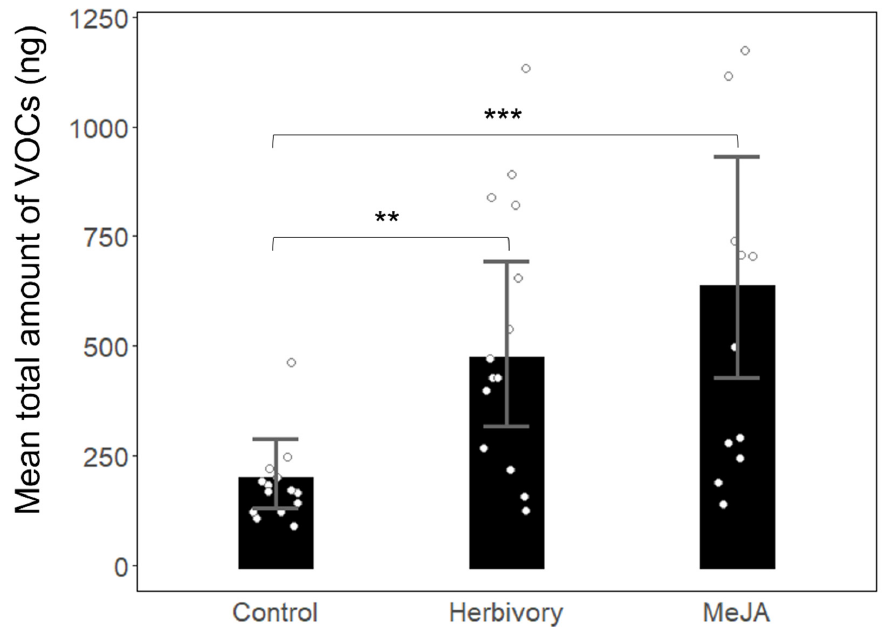
Figure 2. The total amount of volatiles (ng) emitted by Control ( n = 15), herbivore-induced ( n = 15), and MeJA-treated ( n = 15) Pyrenean oaks at a study site in an oak forest of Guadarrama Mountains, Spain. Treatments with significantly different amounts of volatiles are marked by asterisks (*** p < 0.001, ** p < 0.01); results of chisq test. White circles show VOCs emitted by each individual tree.